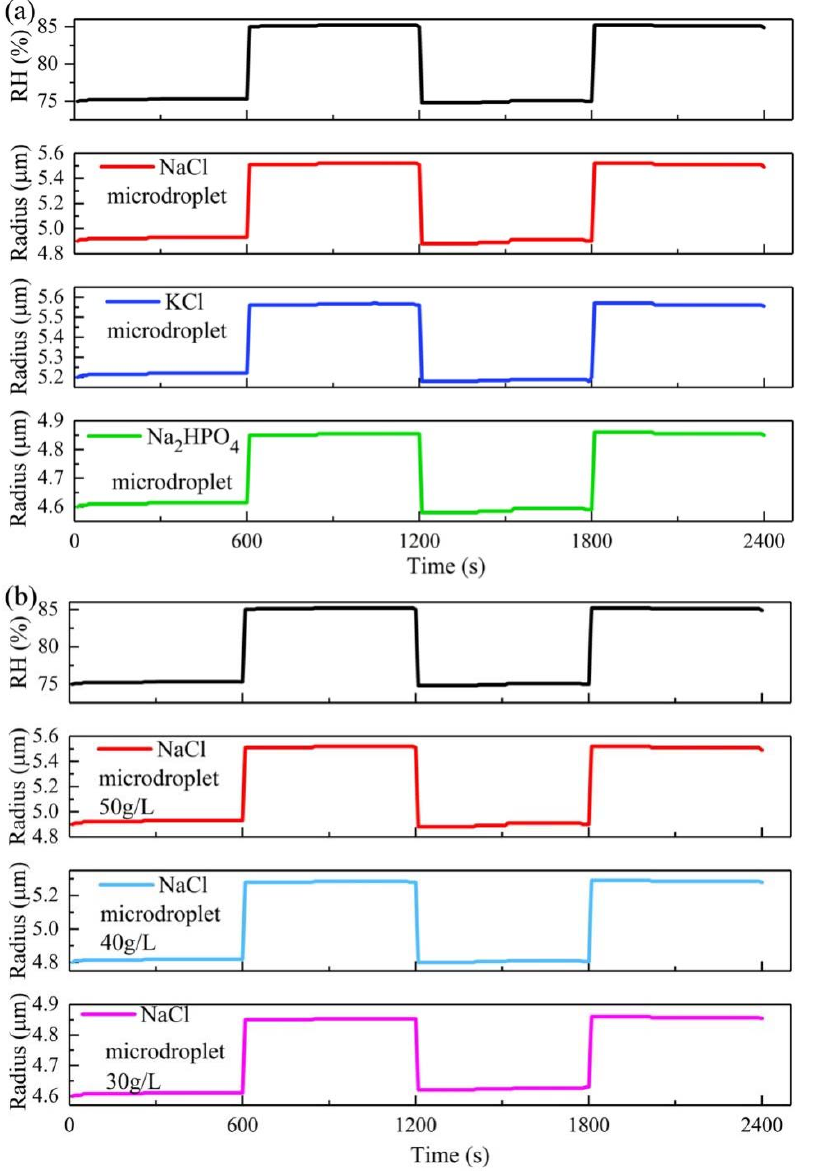
Figure 5. ( a ) Growth of different types of microdroplets and ( b ) NaCl microdroplets of different concentrations under the conditions that the ambient relative humidity (RH) changes between 75 and 85%.